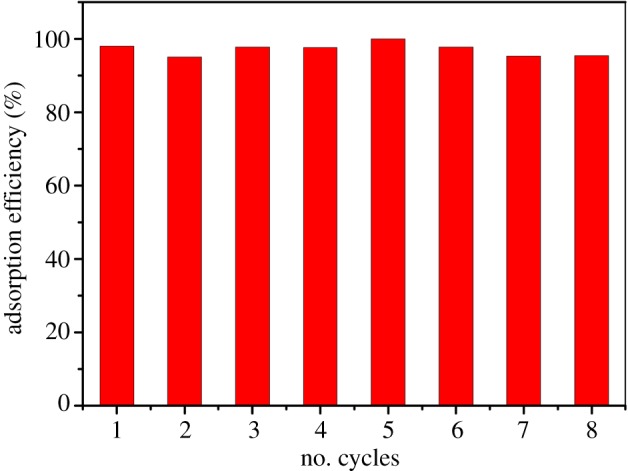
The reusability of the Fe@SiO2@MIP adsorbents.